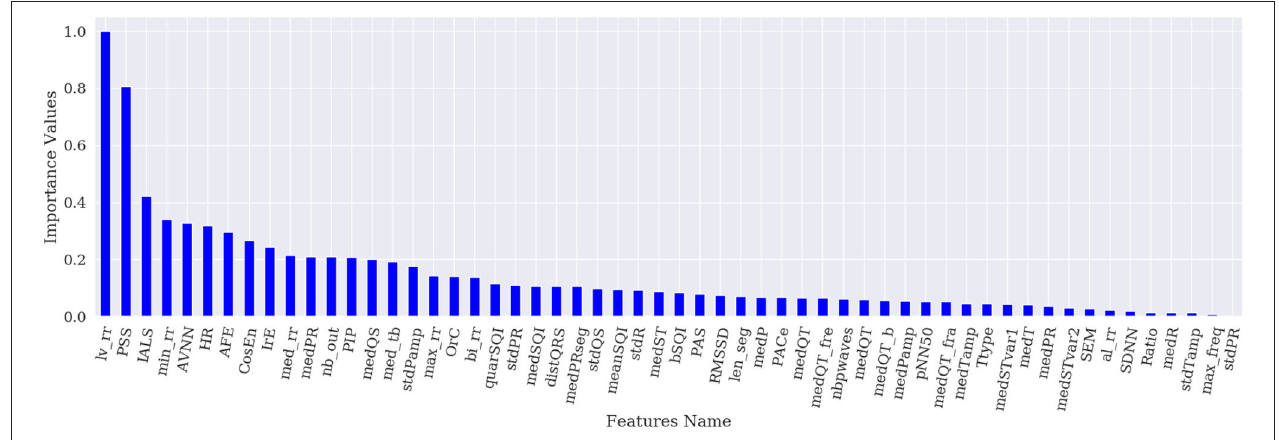
FIGURE 4 | Feature importance based on SHAP.